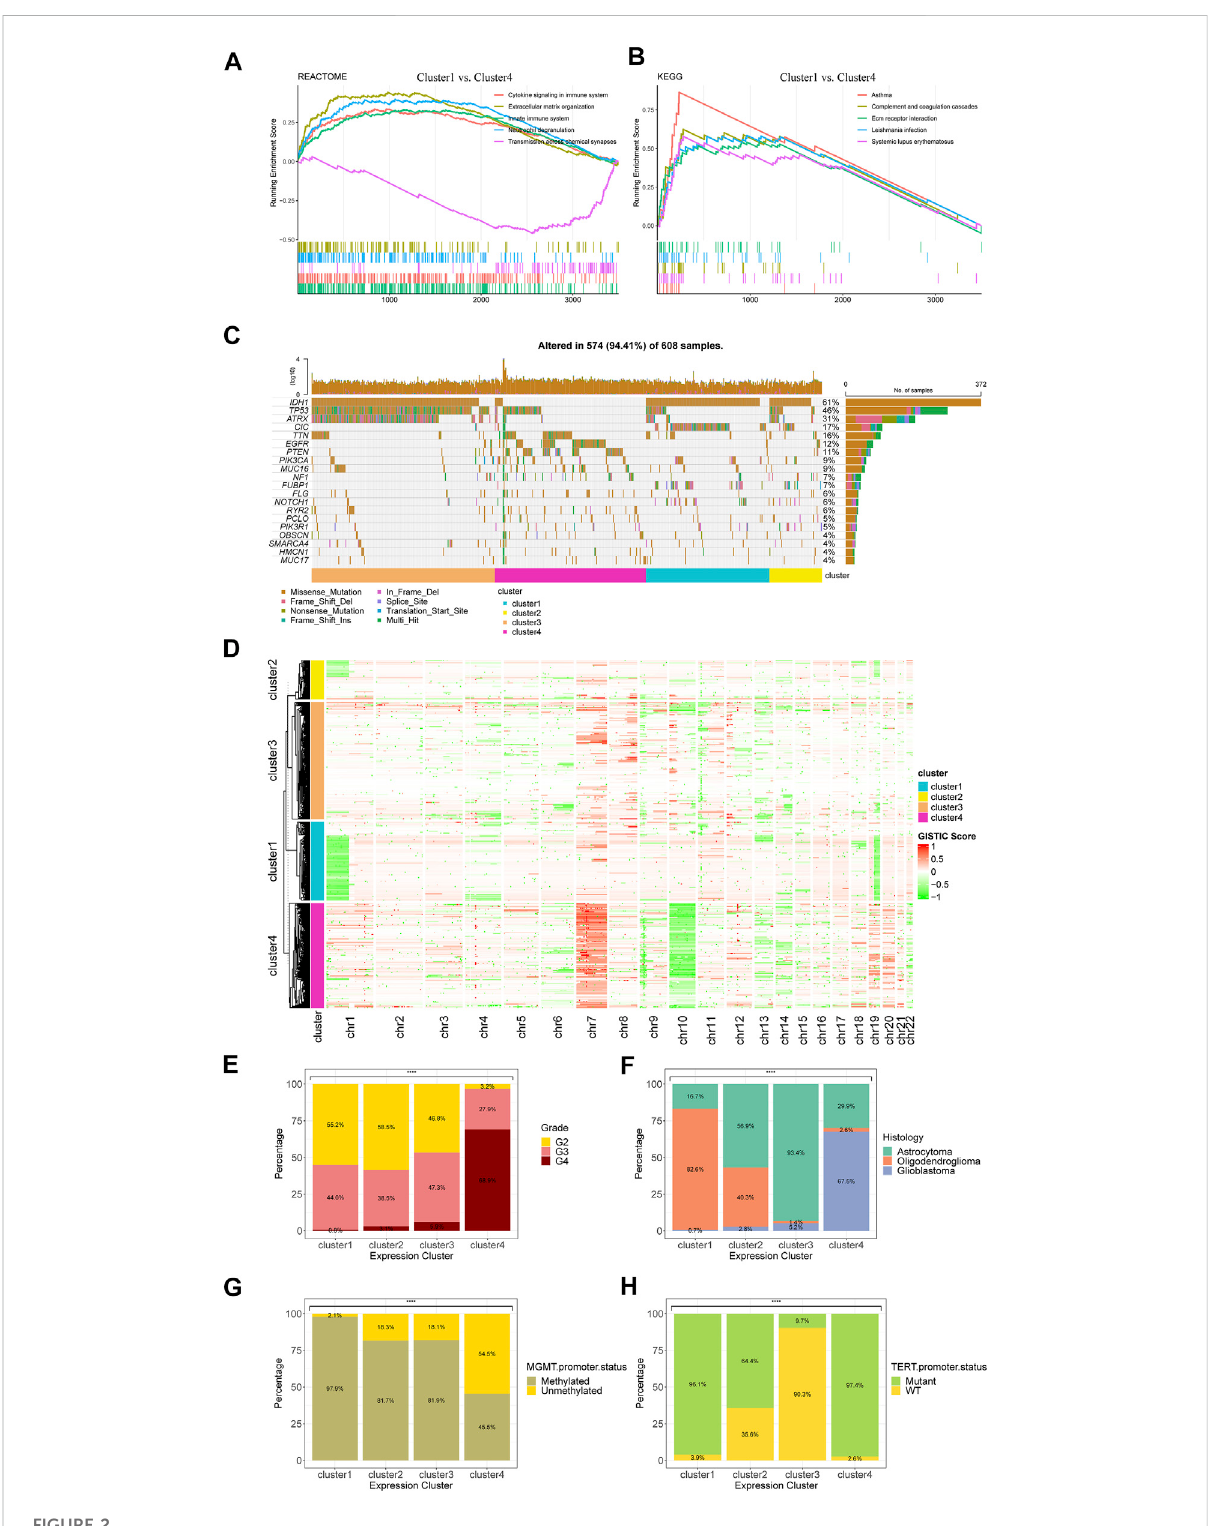
FIGURE 2 Functional enrichment and clinicopathological characteristics of the four consensus clusters in TCGA cohort. (A) Top fi ve pathways with the highest NES in the REACTOME gene set between cluster 1 and cluster 4. (B) Top fi ve pathways with the highest NES in the KEGG gene set between cluster1andcluster4. (C) Top20mutatedgenesofthefourconsensusclusters. (D) Heatmapforcopynumbervariationsofthefourclusters. (E) The differences in (E) tumor grade, (F) histological diagnosis, (G) MGMT promoter status, and (H) TERT promoter status among four clusters. * p